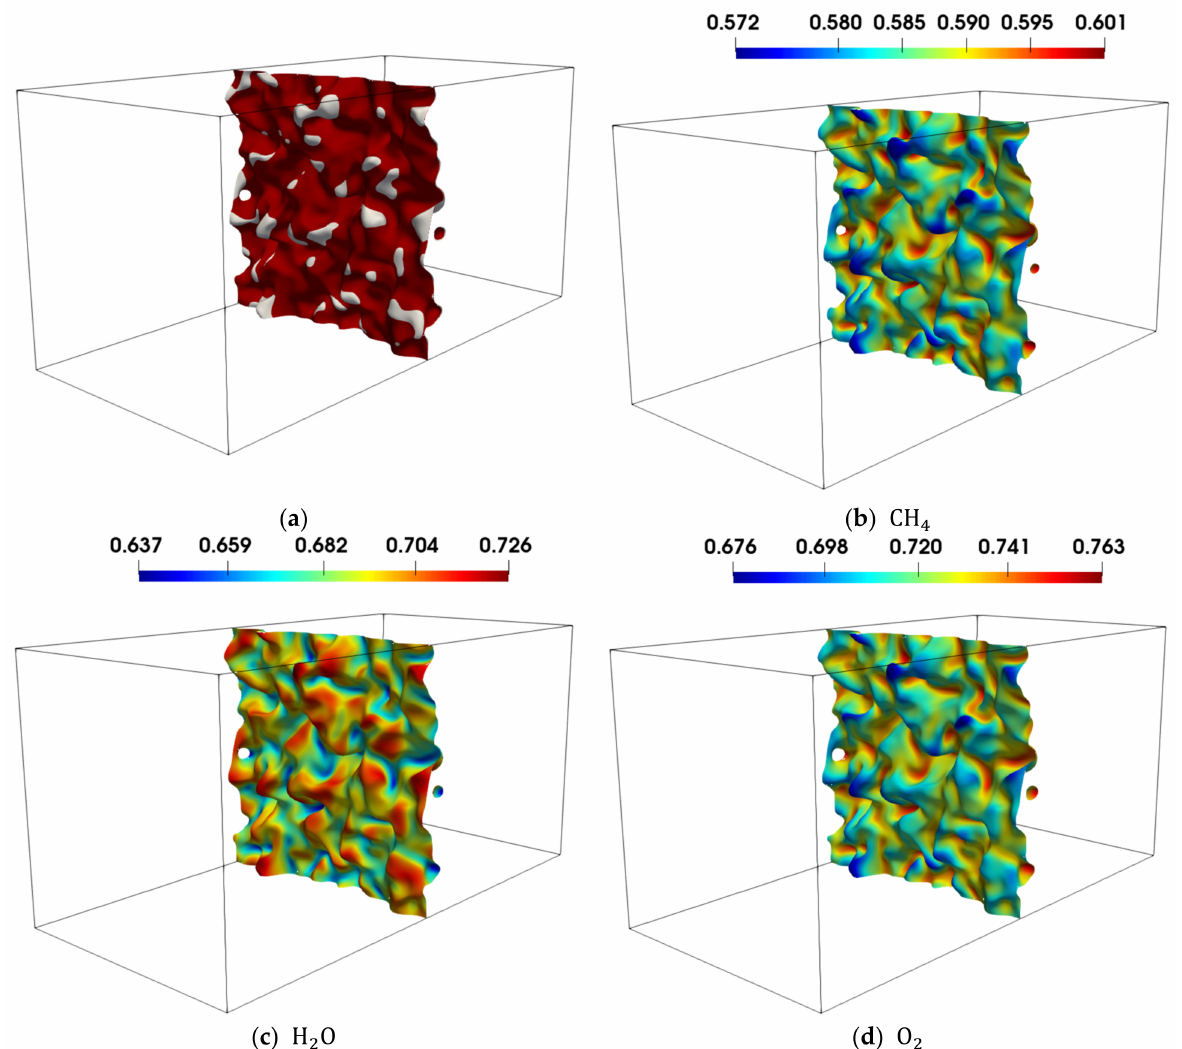
Figure 20. ( a ) Simultaneous plot of isosurfaces of reaction progress variable c = 0.8 for H 2 O (red) and O 2 (grey). ( b – d ) Iso- surfaces of reaction progress variable c coloured with non-dimensional temperature for case AD for reaction progress variable based on ( b ) CH 4 ( c ) H 2 O ( d ) O 2 mass